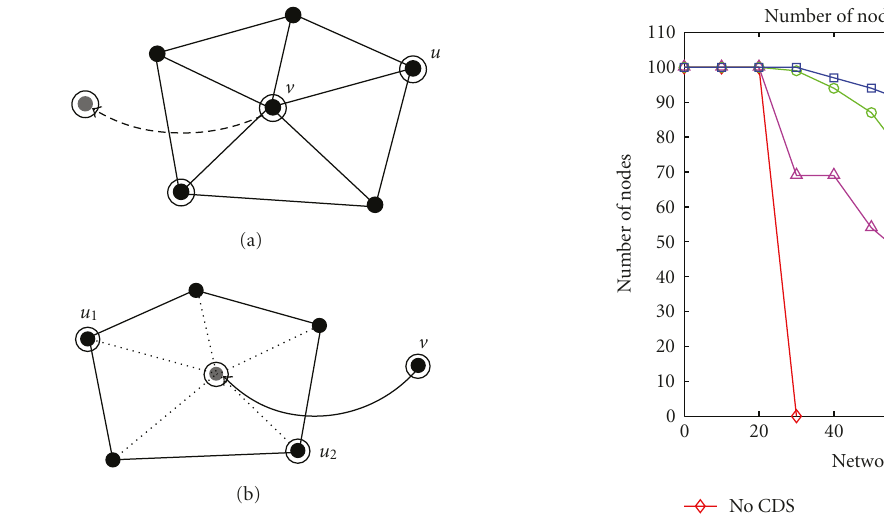
ff erent models.